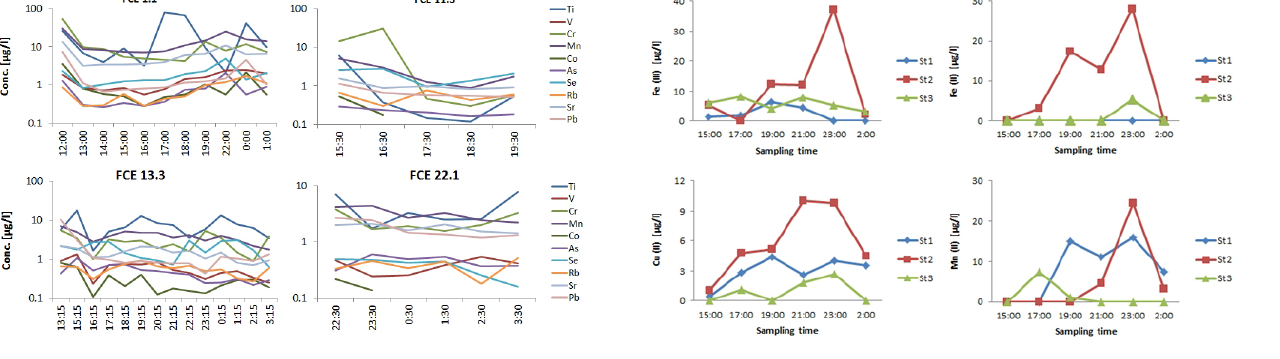
Fig. 7. The nominal cloud water size cutoffs were 22, 16, and 4 µm for stages (St.) 1, 2, and 3, respectively. Fe(II) was mainly found on the second stage (size range: 16–22 µm) with concentrations of up to 28.2 µg L − 1 meanwhile Fe(III) was found on all of the stages during the event with observed concentrations ranging up to 37.1 µg L − 1 . The lowest con- centration of Fe(III) was found in the larger droplets (stage 1). Soluble Cu(II) was concentrated in the first and second stages, likewise Mn(II). The Cu(II) concentrations ranged from 0.4 to 10.5 µg L − 1 with higher concentrations observed on the second stage. Mn(II) concentrations varied from